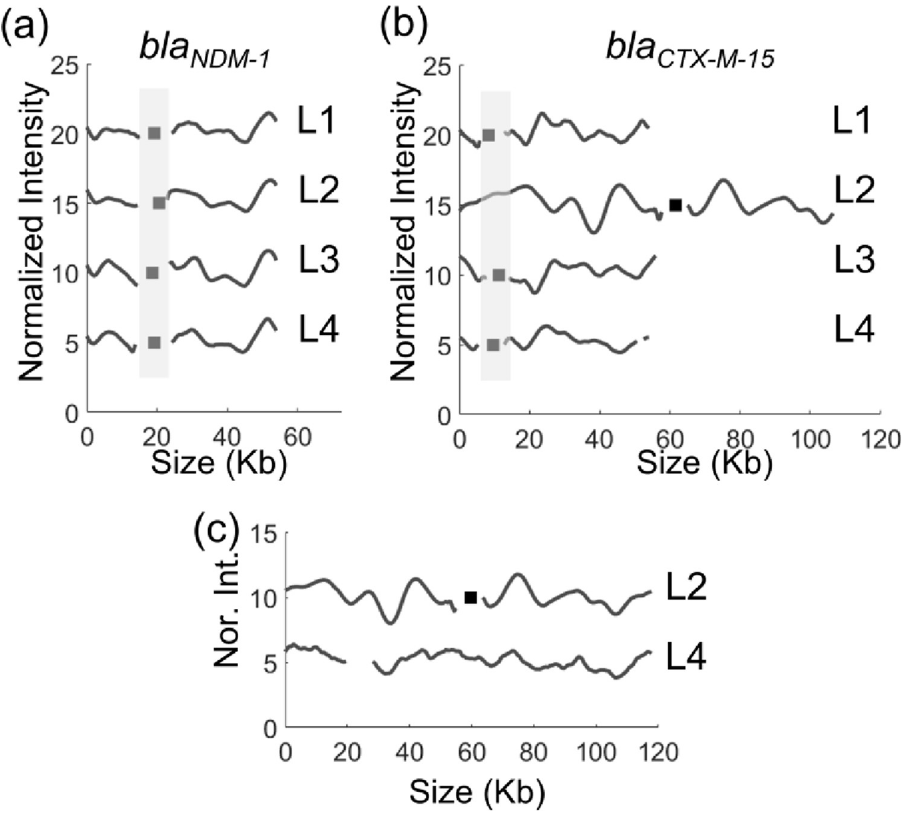
Fig 3. The barcode and gene location of the bla NDM-1 gene (a) and the bla CTX-M-15 gene (b) on plasmids isolated from the four carbapenemase-producing isolates L1-L4. (c) ~118 kb plasmid identified in isolates L2 and L4, the plasmid in L2 had the bla CTX-M-15 gene while L4 had neither the bla NDM-1 nor the bla CTX-M-15 gene. Black squares represent the gene location. The x-axis shows the size of plasmids in kb and the y-axis is the normalized intensity in arbitrary units, where the barcode of each isolate is shifted vertically by five units for